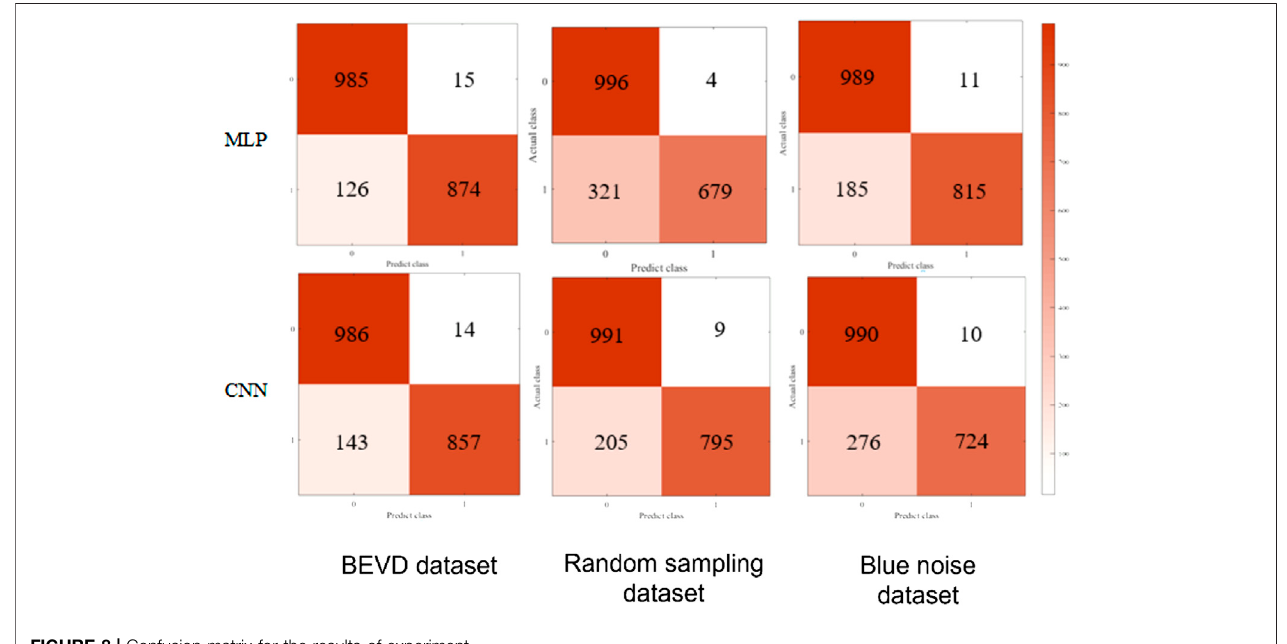
FIGURE 8 | Confusion matrix for the results of experiment.